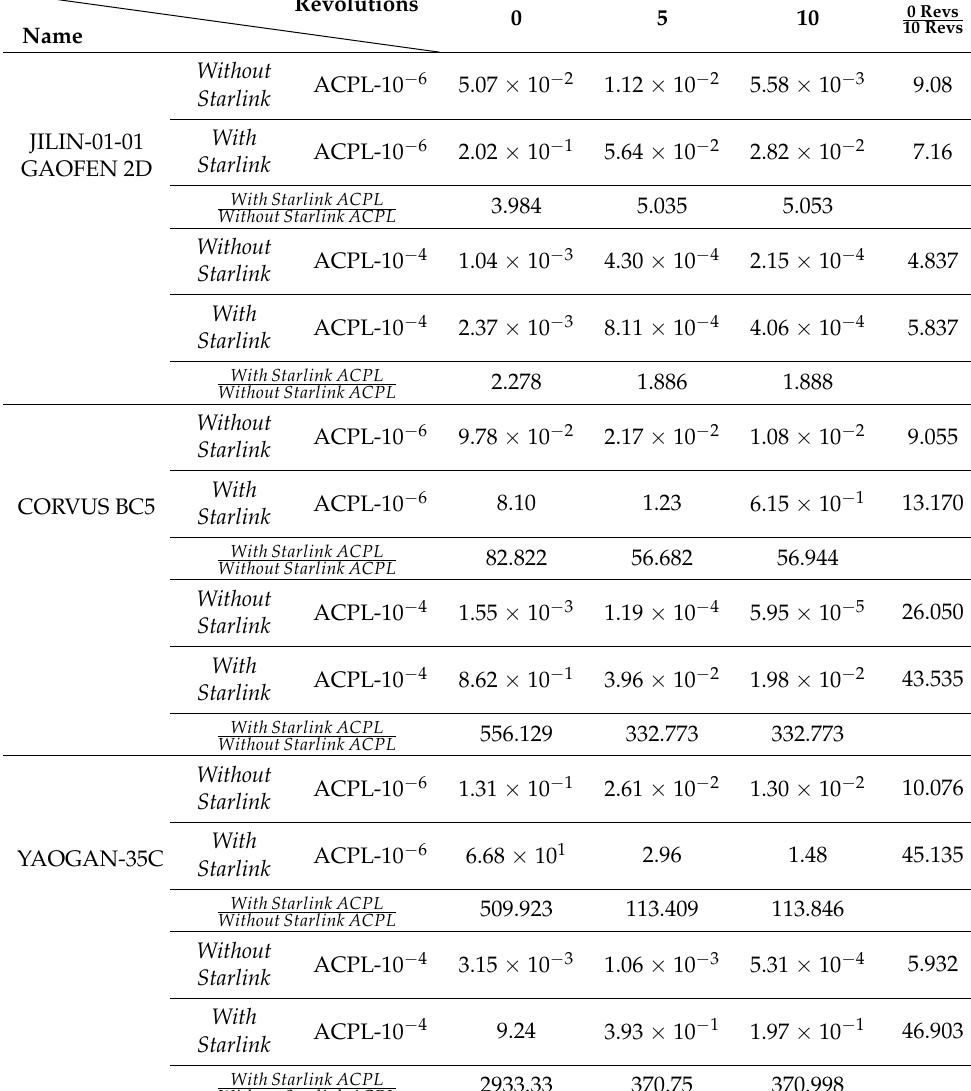
Table 4. Comparison of data from ∆ V in Figure